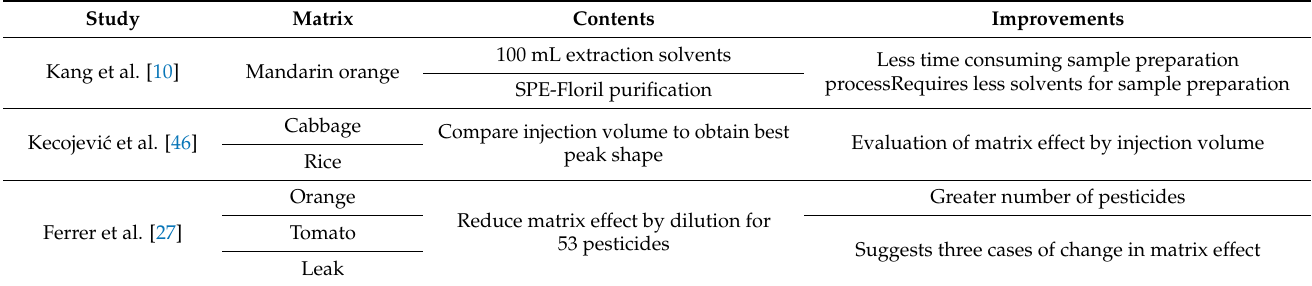
Table 1. Improvements achieved in our study compared to previous